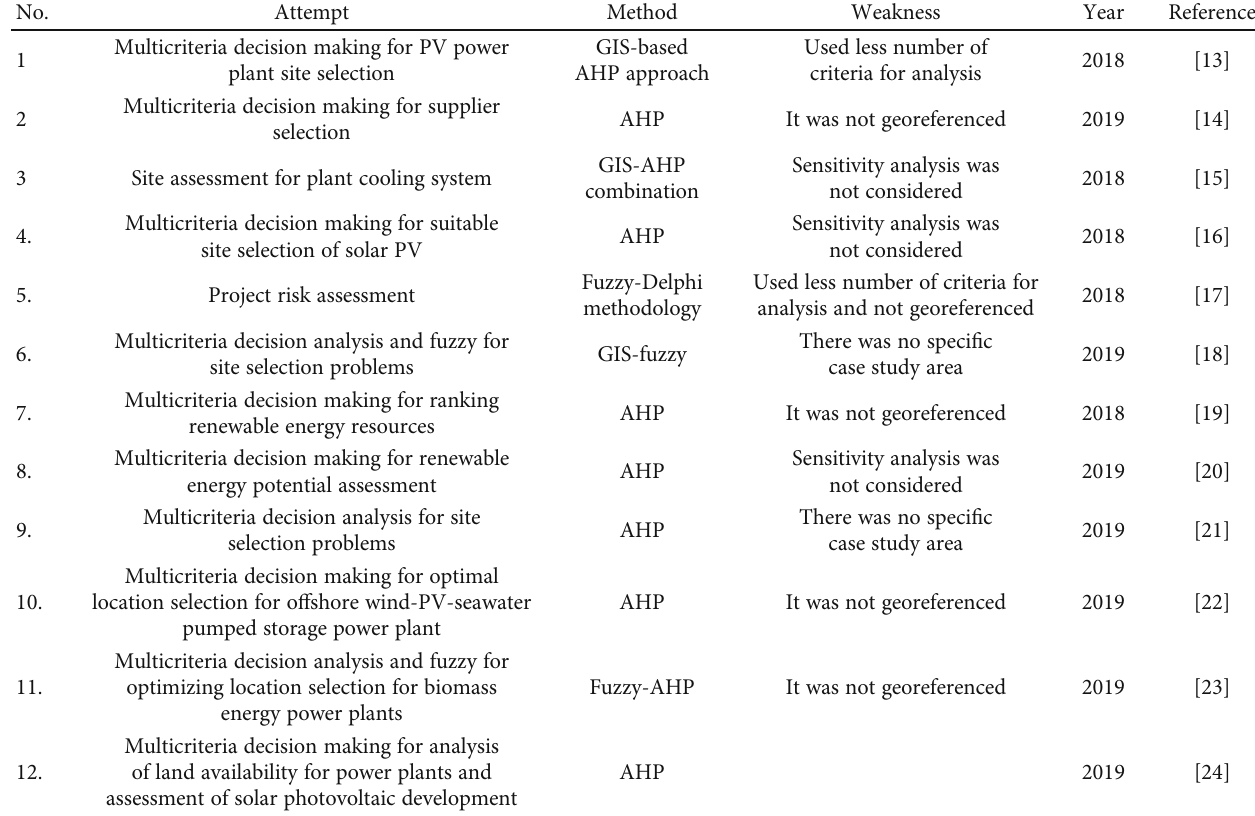
Table 1: Site suitability analysis-related studies with multicriteria perspectives.